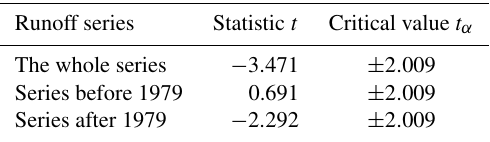
Table 2. Spearman correlation test results of runoff series trend. Table 3. Linear regression relationship between cumulative precip- itation ( x per mm) and cumulative runoff ( y per 10 6 m 3